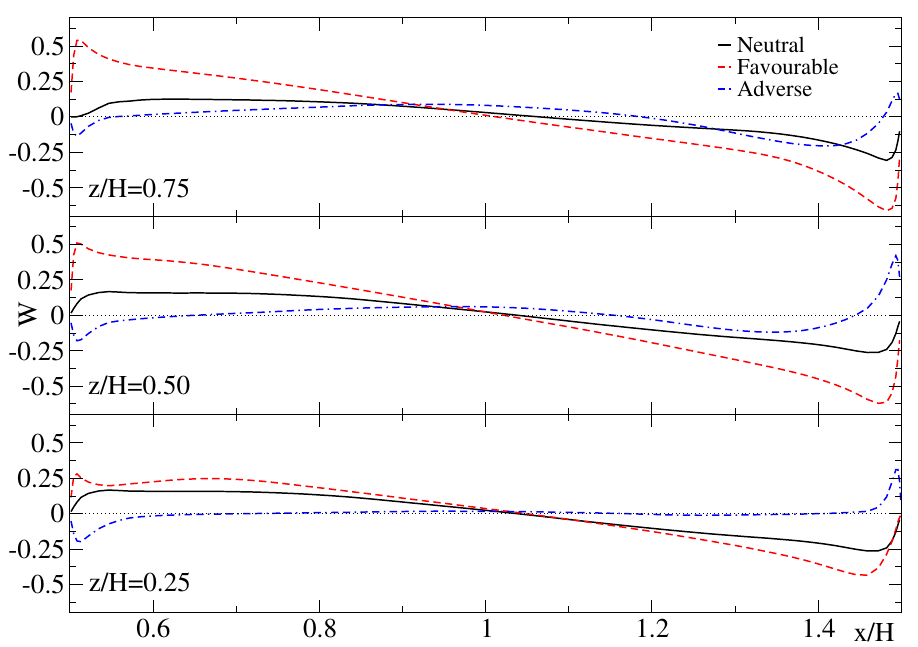
Figure 6. Non-dimensional mean vertical velocity, W = (cid:104) w (cid:105) / U 0 , along three selected horizontal lines z / H =